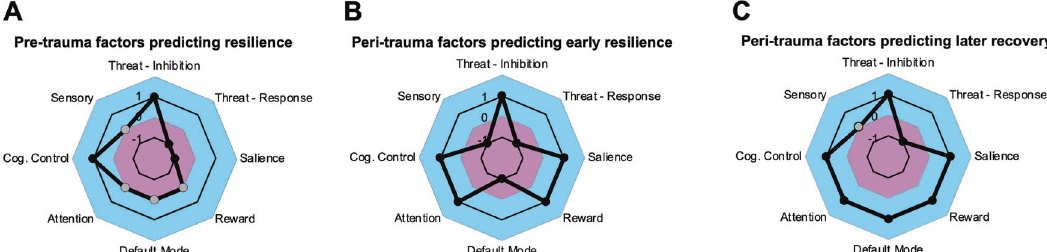
Fig. 2 Network-level features predicting resilience, over time relative to trauma exposure. Across time following trauma, network patterns are noticeable. Pre-trauma fi ndings ( A ) suggest that structural integrity/activation of inhibition areas in the threat and cognitive control networks positively correlate with resilience, while threat response and salience networks show negative associations with resilience. Post- trauma fi ndings are split into two categories: early, peri-trauma fi ndings that predict early resilience within the fi rst year following trauma ( B ) and peri-trauma fi ndings that predict later recovery and resilience years following the trauma ( C ). Correlations for the inhibitory and response areas of the threat network and cognitive control network are consistent over all three timepoints, and across the two post-trauma timepoints, the attention and reward networks both have positive correlations with resilience. However, some networks exhibit changes across time points. The DMN during peri-trauma negatively predicts early resilience, while it positively predicts later recovery and resilience. Changes are also seen across the salience network, with less salience activation pre-trauma predicting resilience, but higher salience activation post-trauma predicting peri-trauma resilience and later recovery. Axis values represent overall negative (purple) or overall positive (blue) correlations. Time points that do not have strong evidence supporting network correlations are indicated by grey